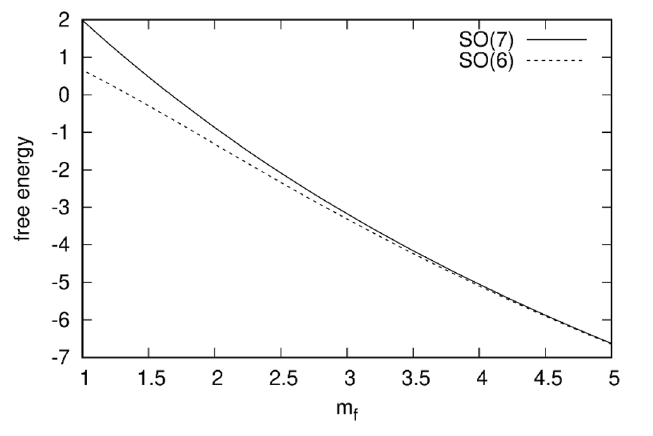
Figure 3 . The free energy calculated up to three loops for the solutions found with the SO(7) and SO(6) ansatzes are plotted against the fermion mass m f . We observe a clear tendency that the SO(6) symmetric vacuum is more favored as m f is decreased, whereas the free energy for the two ansatzes tends to be degenerate as m f is increased.